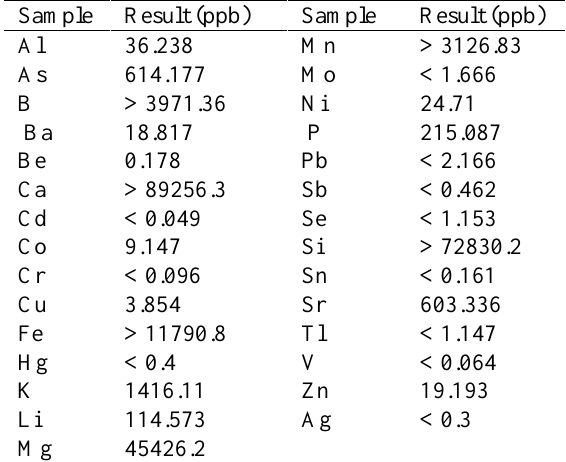
measurement by the ICP-AES technique of the collected water